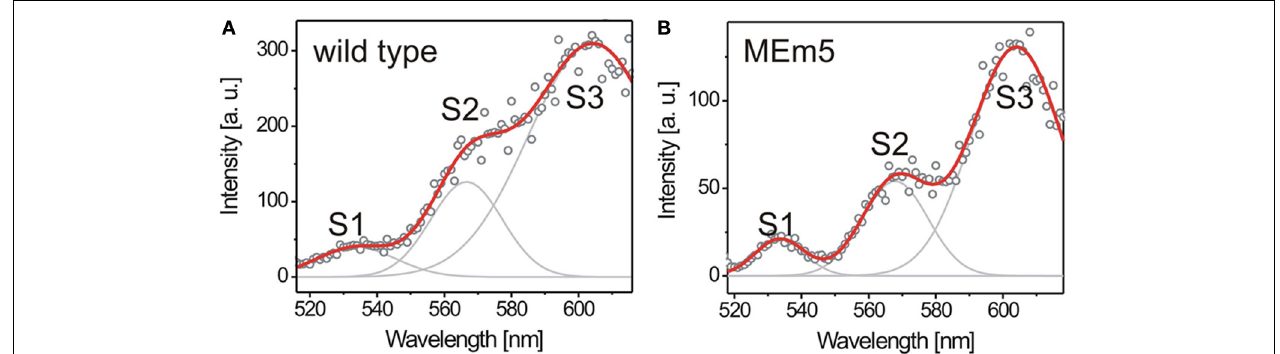
FIGURE 3 | Fluorescence excitation spectra of chloroplasts recorded from 5-week-old A. thaliana wild type (100 spectra) (A) and MEm5 (150 spectra) (B). The plants were grown at white light (50 μ mol quanta m 2 s − 1 ) under SD conditions. Three transitions contributing to the energy migration chain are visible as distinct bands. The spectral envelope was fitted by three